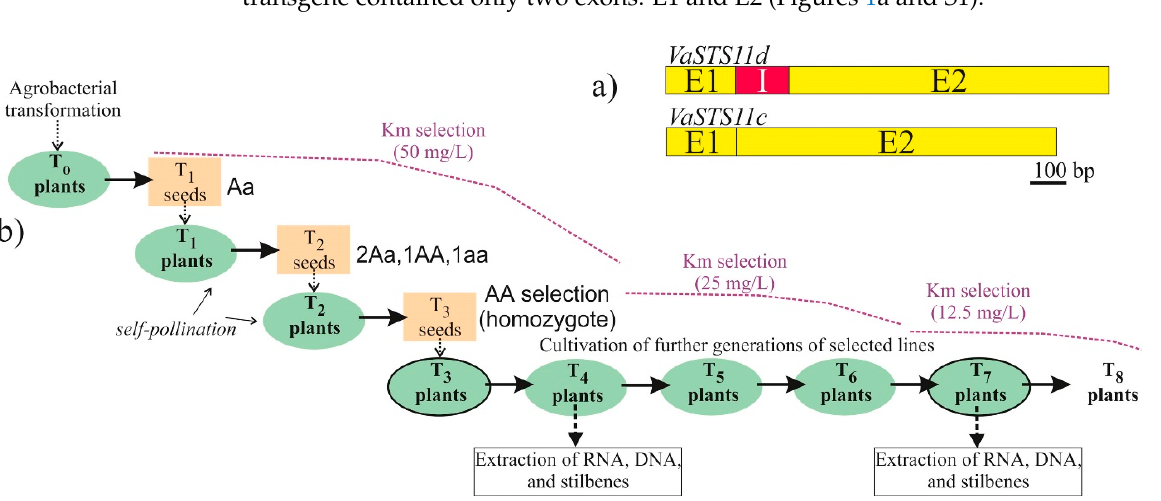
Figure 7. ( a ) Schematic representation of the VaSTS11d and VaSTS11c transgene; E1—first exon; I—intron; E2—second exon. ( b ) Schematic representation of the selection procedure for transgenic Arabidopsis thaliana ; T 0 —transformed A. thaliana plants; T 1 –T 8 —different generations of A. thaliana transgenic plants; Km—kanamycin.